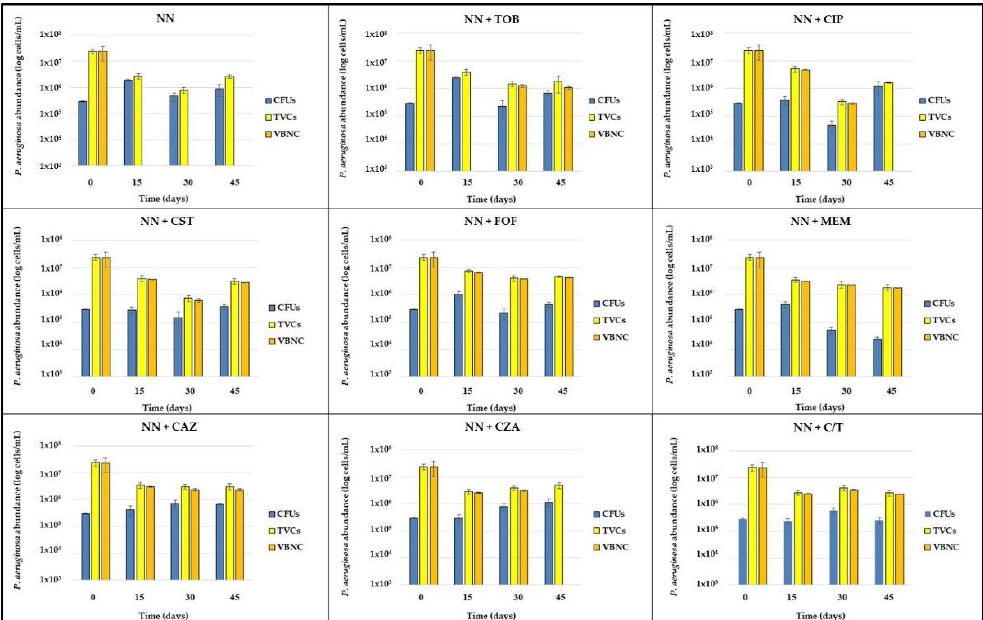
Figure 5. P. aeruginosa populations monitoring in starved and antibiotic-exposed biofilms. P. aeruginosa biofilms, developed in rich medium, were exposed 1000 × MIC piperacillin for 24 h (T0), then subcultured in non-nutrient broth, alone or supplemented with 1/4 × MIC of different antibiotics, and maintained in these conditions for 45 days. The amount of the different P. aeruginosa subpopulations was monitored every 15 days (T15, T30 and T45) by a combination of cultural, qPCR and flow cytometry assays. The results are expressed as average of three biological replicates ± standard deviation. NN, non-nutrient; TOB, tobramycin; CIP, ciprofloxacin; CST, colistin; FOF, Fosfomycin; MEM, meropenem; CAZ, ceftazidime; CZA, ceftazidime/avibactam; C/T, ceftolozane/tazobactam; CFUs, colony forming units; TVCs, total viable cells; VBNC, viable but non-culturable cells.